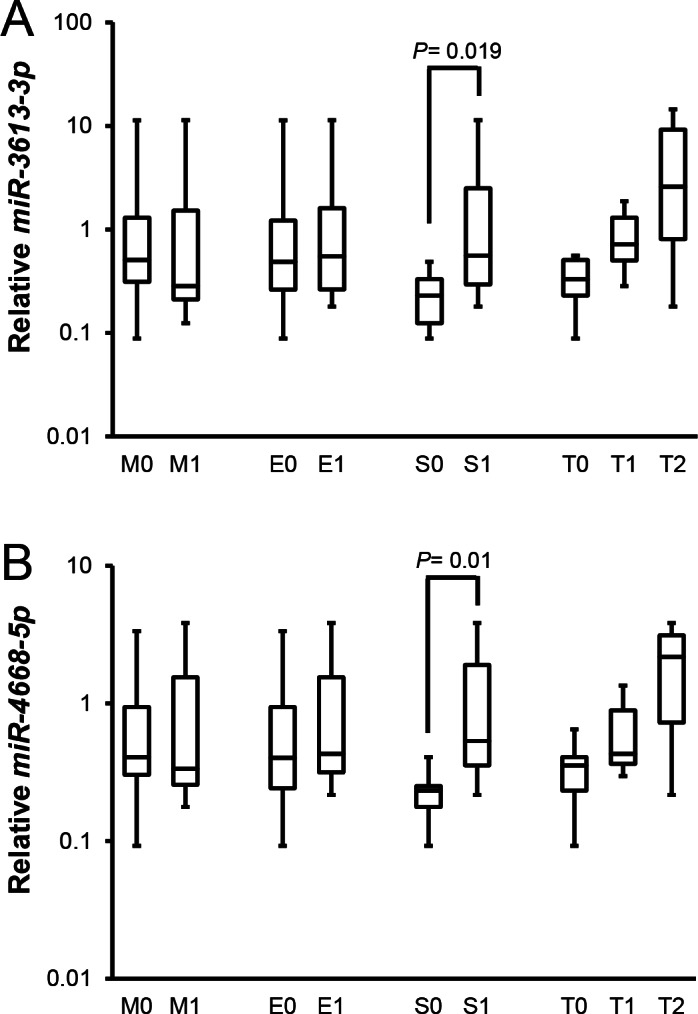
Relationships between candidate miRNAs levels and pathological parameters in patients with IgAN according to Oxford classification.The whisker-box plots with medians and inter-quartile ranges depict the relative expression level of miR-3613-3p and miR-4668-5p. Data were analyzed by Mann–Whitney U test. IgAN, IgA nephropathy; HC, healthy control; MN, membranous nephropathy; MCD, minimal change disease. (A) Urinary miR-3613-3p levels of patients with S1 were higher than patients with S0 [0.56 (0.29–2.5), n = 69 vs. 0.23 (0.12–0.33), n = 33; P = 0.019]. Urinary miR-3613-3p levels of patients with M1/M0, E1/E0 and T2/T1/T0 were not different between each other [0.28 (0.21–1.52), n = 43 vs. 0.51 (0.31–1.3), n = 59; 0.55 (0.26–1.61), n = 13 vs. 0.49 (0.26–1.22), n = 89; 2.58 (0.81–9.18), n = 9 vs. 0.72 (0.5–1.3) vs. 0.33 (0.23–0.51), n = 56]. (B) Urinary miR-4668-5p levels of patients with S1 were higher than patients with S0 [0.53 (0.35–1.9), n = 69 vs. 0.23 (0.18–0.25), n = 33; P = 0.019]. Urinary miR-4668-5p levels of patients with M1/M0, E1/E0 and T2/T1/T0 were not different between each other [0.33 (0.26–1.55), n = 43 vs. 0.41 (0.3–0.94), n = 59; 0.43 (0.32–1.55), n = 13 vs. 0.4 (0.24–0.94), n = 89; 2.18 (0.73–3.13), n = 9 vs. 0.43 (0.36–0.89) vs. 0.35 (0.23–0.41), n = 56].